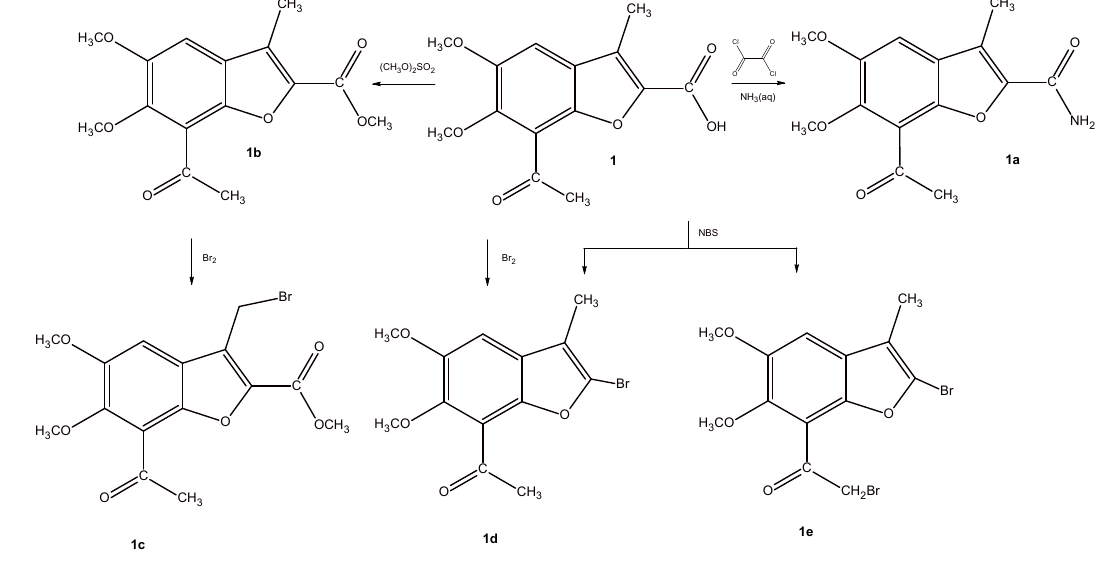
Scheme 1. Synthesis of analogues of compound VIII .